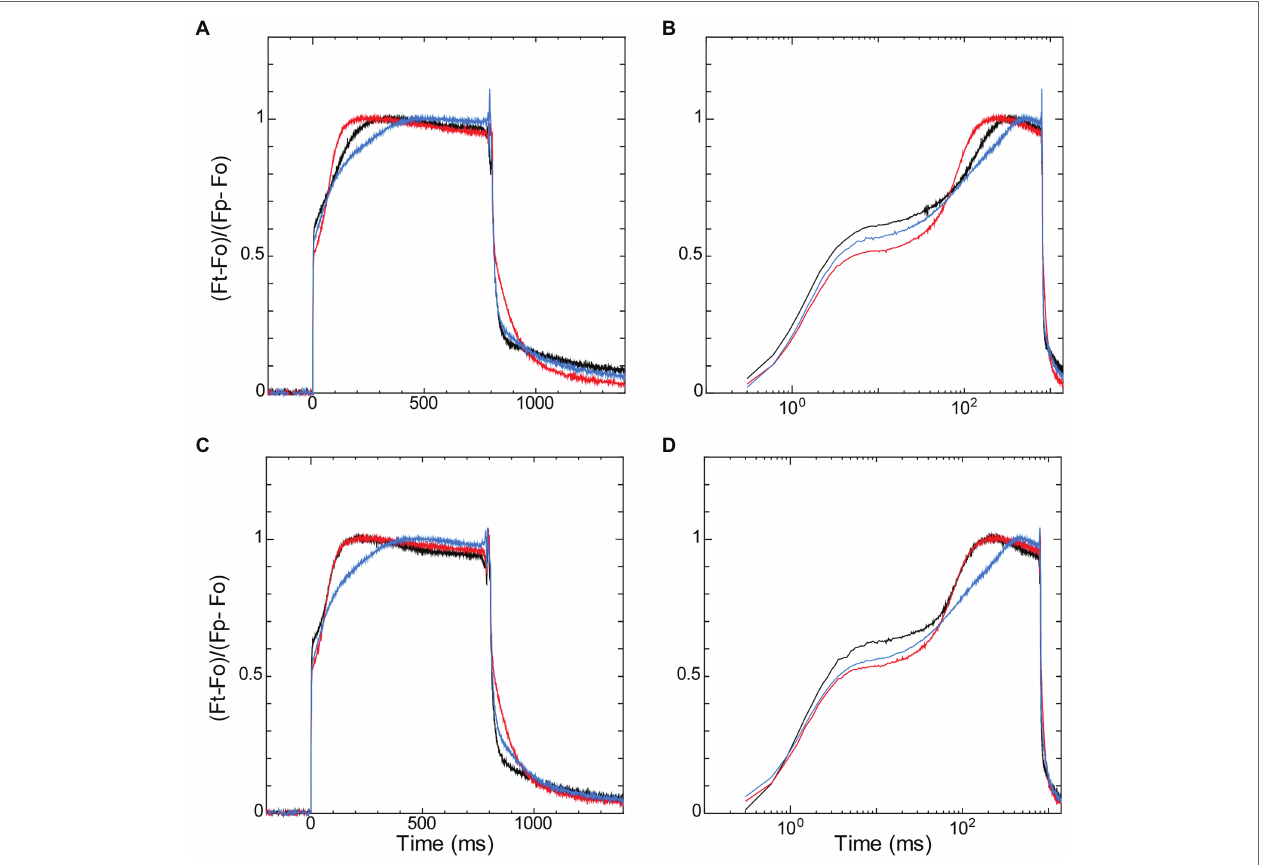
FIGURE 4 | The dark-to-light induction kinetics of chlorophyll fluorescence upon saturating pulse of 800 ms measured in parallel with NADPH fluorescence ( Figure 2 ) in the absence (A,B) or presence (C,D) of glucose. Fluorescence data on the left panels (A,C) are plotted against linear scale and the right panels (B,D) are plotted against logarithmic scale. Black line, the wild-type strain; red line, Δ ndhF1 ; and blue line, Δ gnd . Fluorescence signals are normalized by Fo and Fp as 0 and 1, respectively (see Materials and Methods). The average of the kinetics of three independent cultures in each strain is